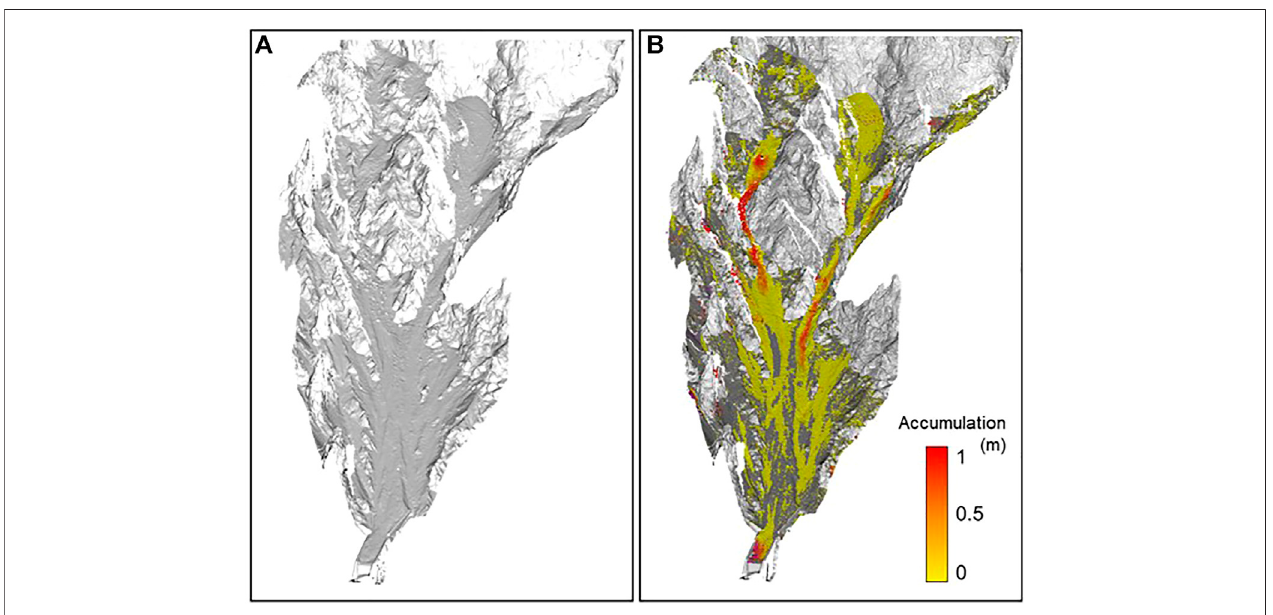
FIGURE 8 | Visual example of the in-channel stored debris volume estimate using the 2 March 2020 WCW Channel 4 scan. (A) Overview of the channel and (B) distance computation between the bedrock baseline model and the 2 March 2020 scan. Color scale denotes distance from the bedrock baseline model.